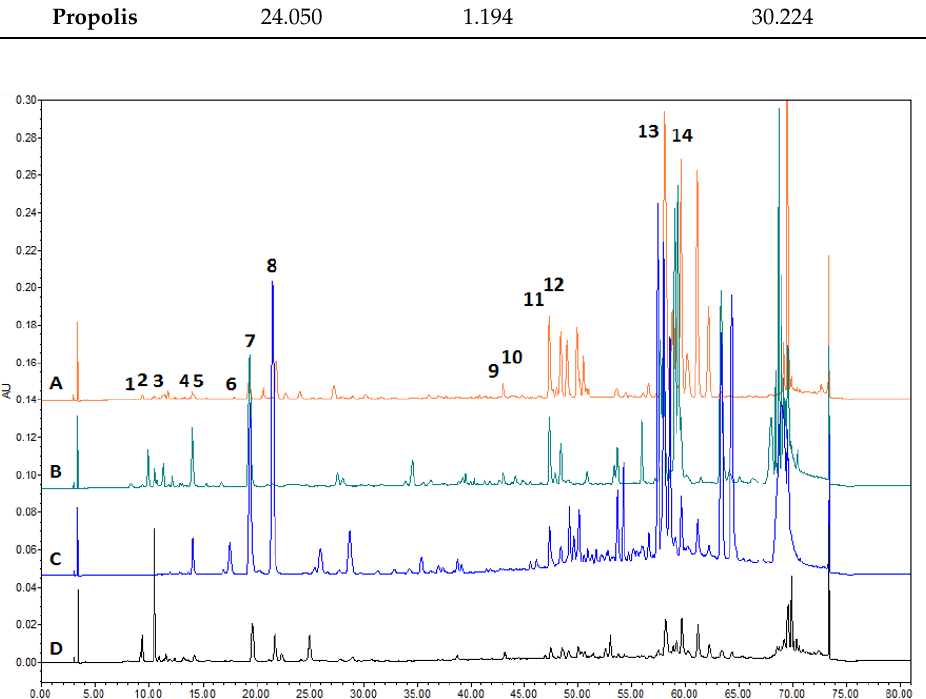
Figure 2. Chromatogram of A — birch buds, B — poplar buds, C — propolis and D — pine buds ex-